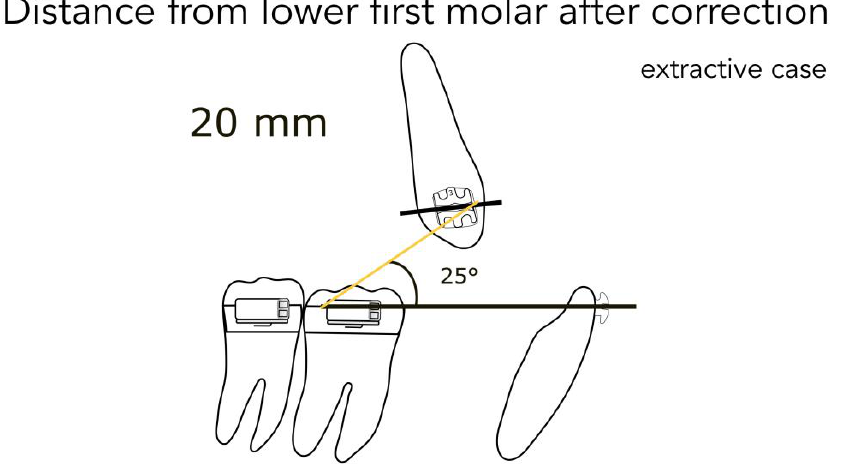
Figure 8. Distance from the lower first molar in the extractive case.